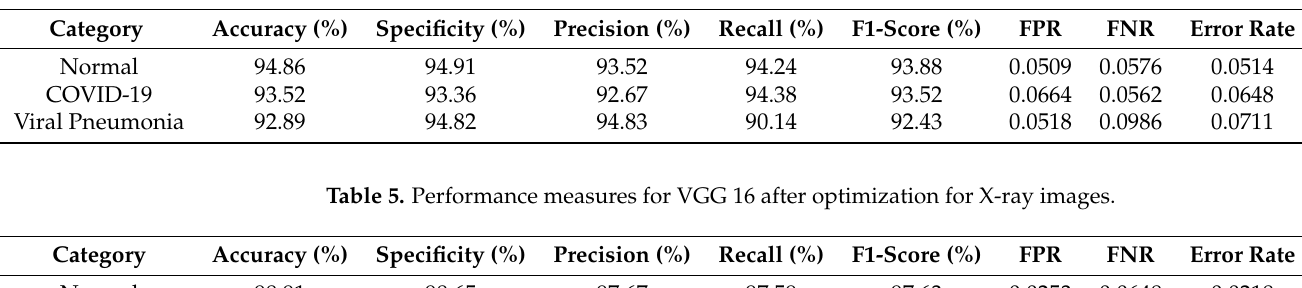
Table 4. Performance measures for VGG 16 without optimization for X-ray images.